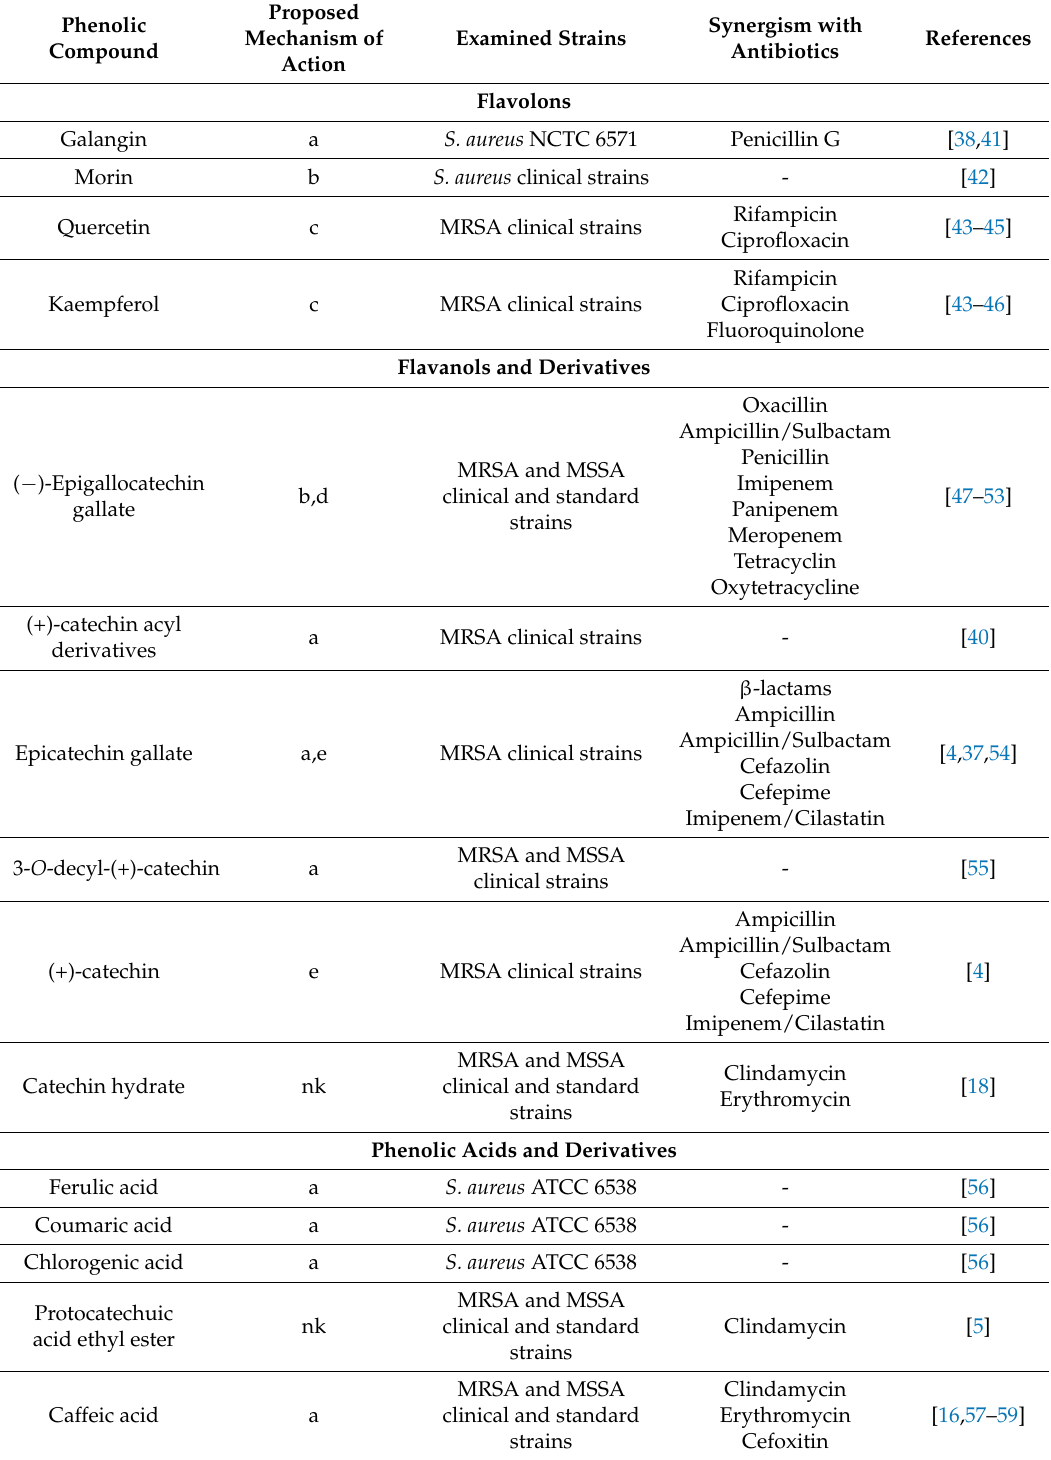
Table 2. Antistaphylococcal properties of flavonols, flavanols and phenolic